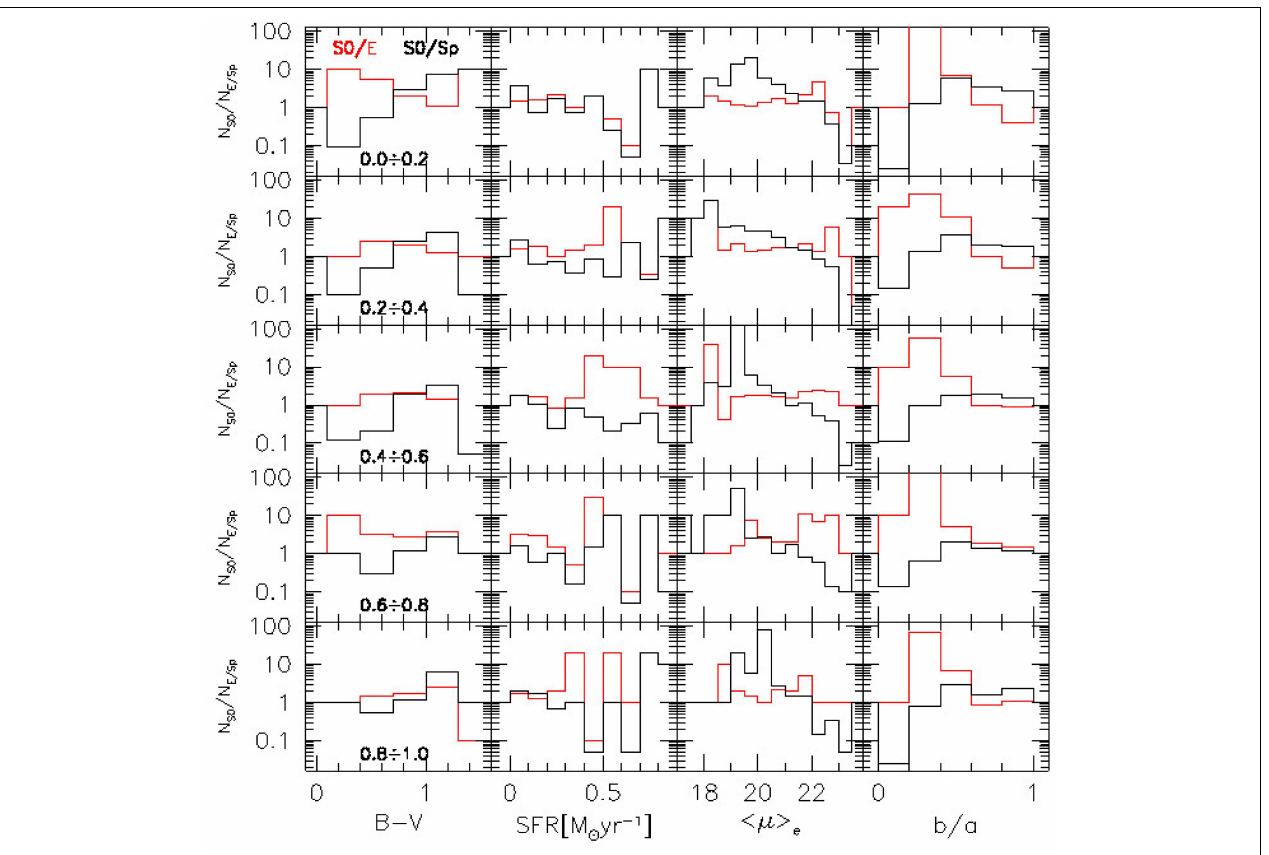
FIGURE 9 | From left to right: the B − V color, the star formation rate (SFR), the mean effective surface brightness ( h µ i e ), and the b / a ratio. As in the previous figure the y-axis gives the ratio between the number of S0’s and Spirals (black line), and S0’s and E’s (red